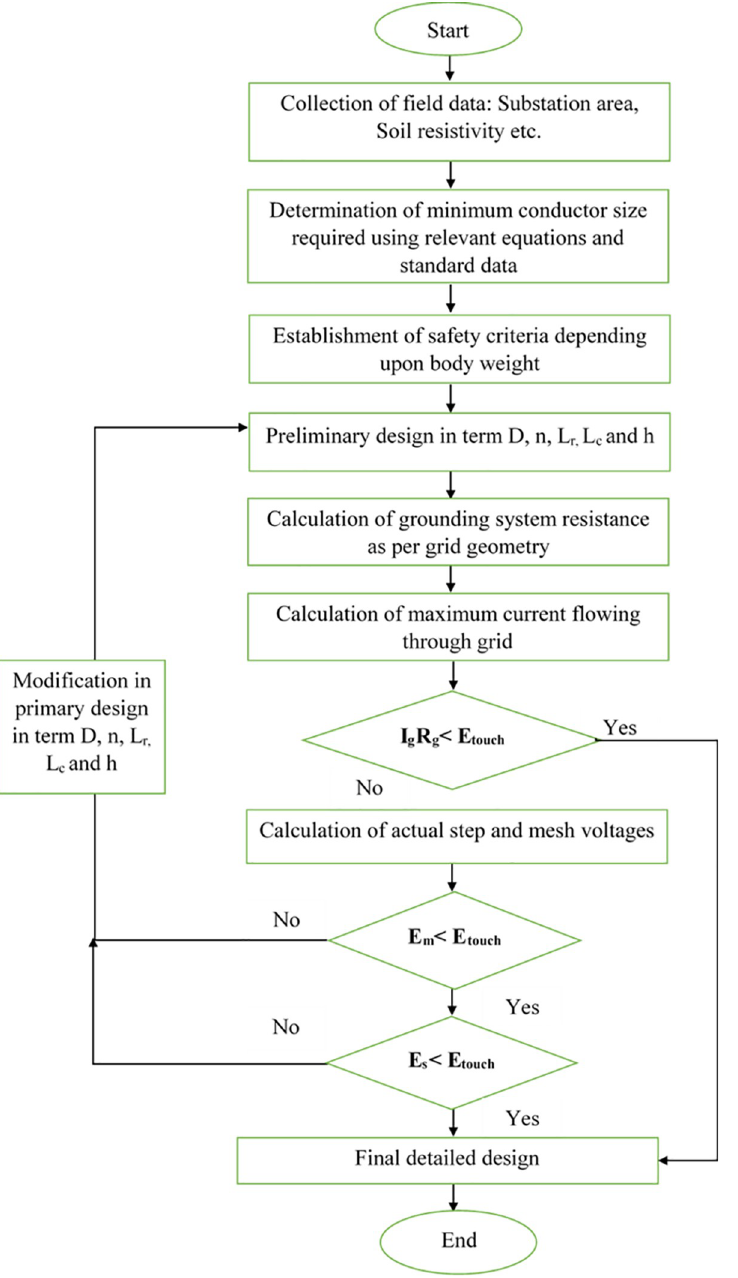
Fig 1. Flowchart of grounding system design methodology according to IEEE 80